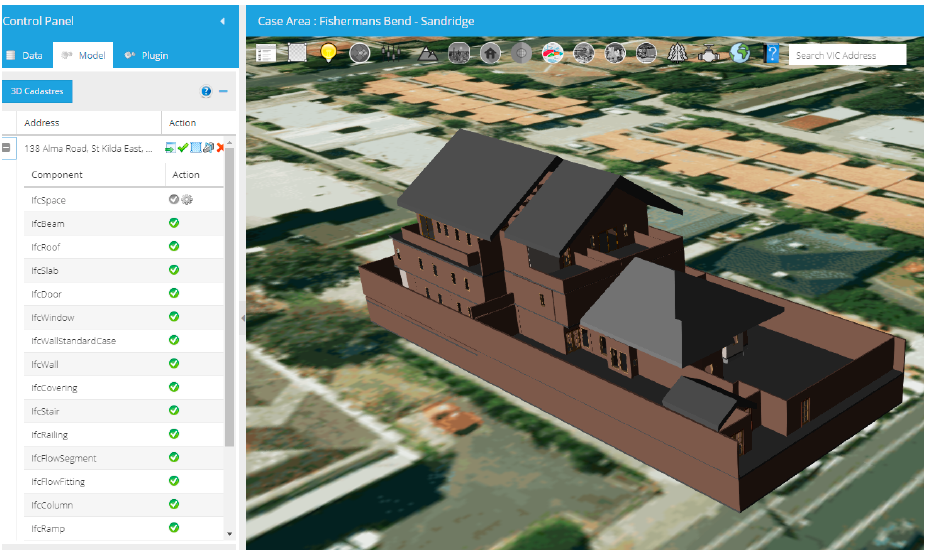
Figure 3. A building in IFC format within the Victorian Government Digital Twin Figure 4. A building in IFC format within the Victorian Government Digital Twin platform.